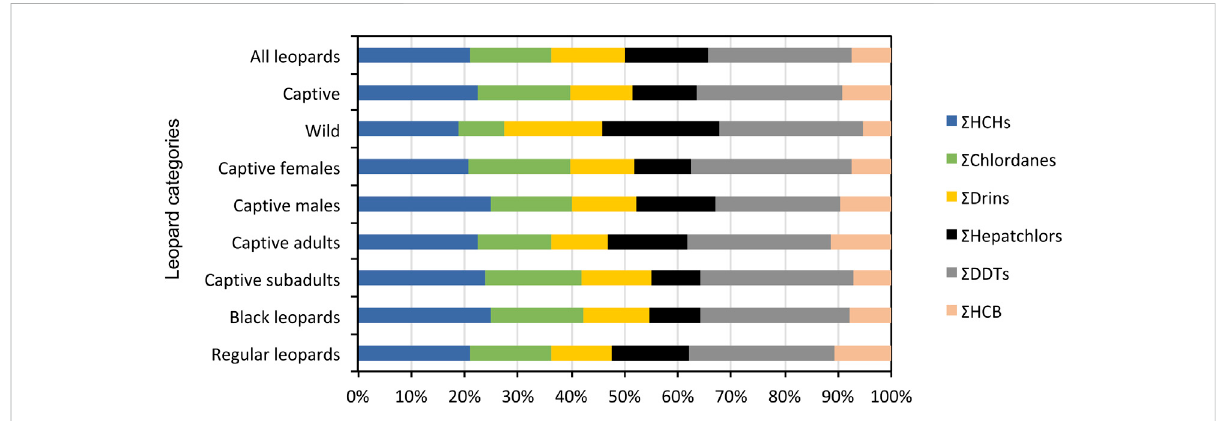
FIGURE 2 The relative contribution of main compound groups ( Σ HCHs; Σ Chlordanes; Σ Drins; Σ Heptachlors; Σ DDTs; Σ HCB) to Σ OCP concentrations as analyzed in all captive and wild